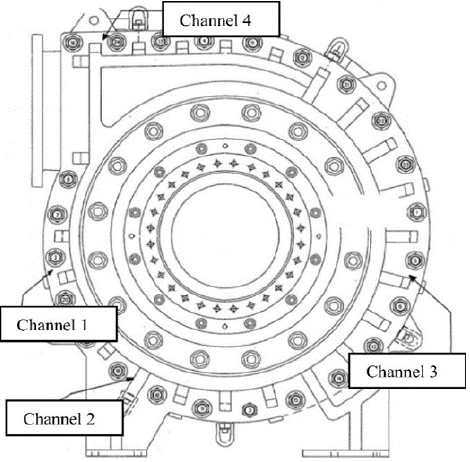
C3, and C4, were mounted on four different locations of the slurry pump, as shown in Figure 2. C1 monitored the vibration at the suction/inlet of the pump, while C2 and C3 were responsible for gathering the vibration signals of the rotating vanes. Lastly, C4 monitored the vibration at the discharge/outlet of the pump. The datasets which were utilized in the conducted research were observed from channel 2, i.e., T2G1 C2, and channel 4, i.e., T2G1 C4.